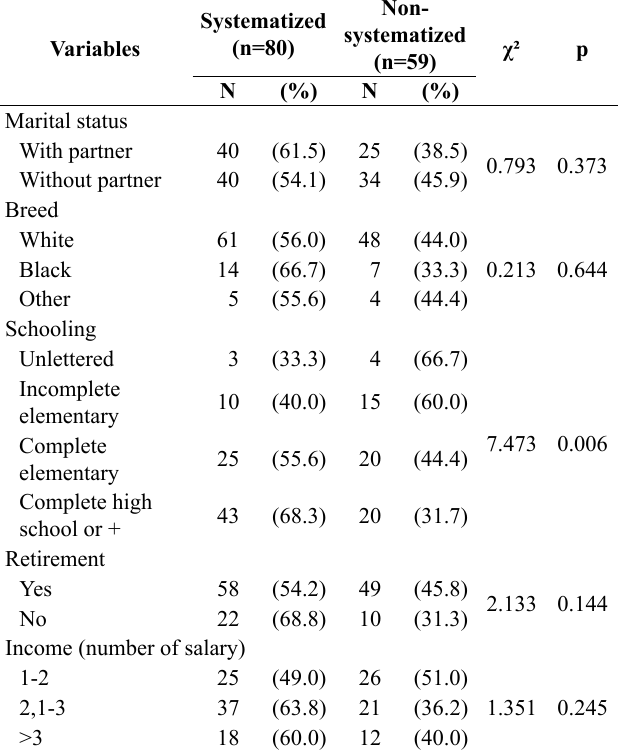
Table 2. Comparison of the proportions of elderly practitioners and non-practitioners of systematized physical exercises according to level of physical activity and perception of the